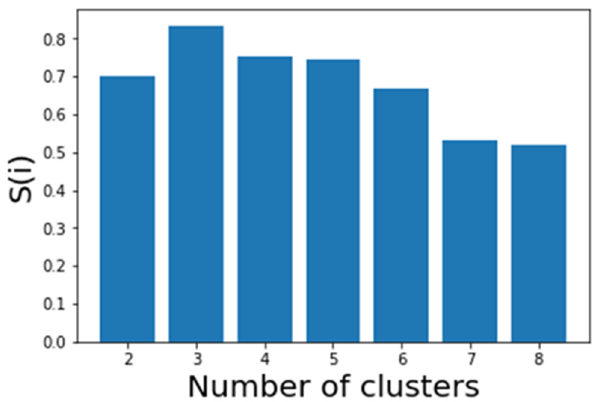
Figure 7. Silhouette index for different numbers of clusters.